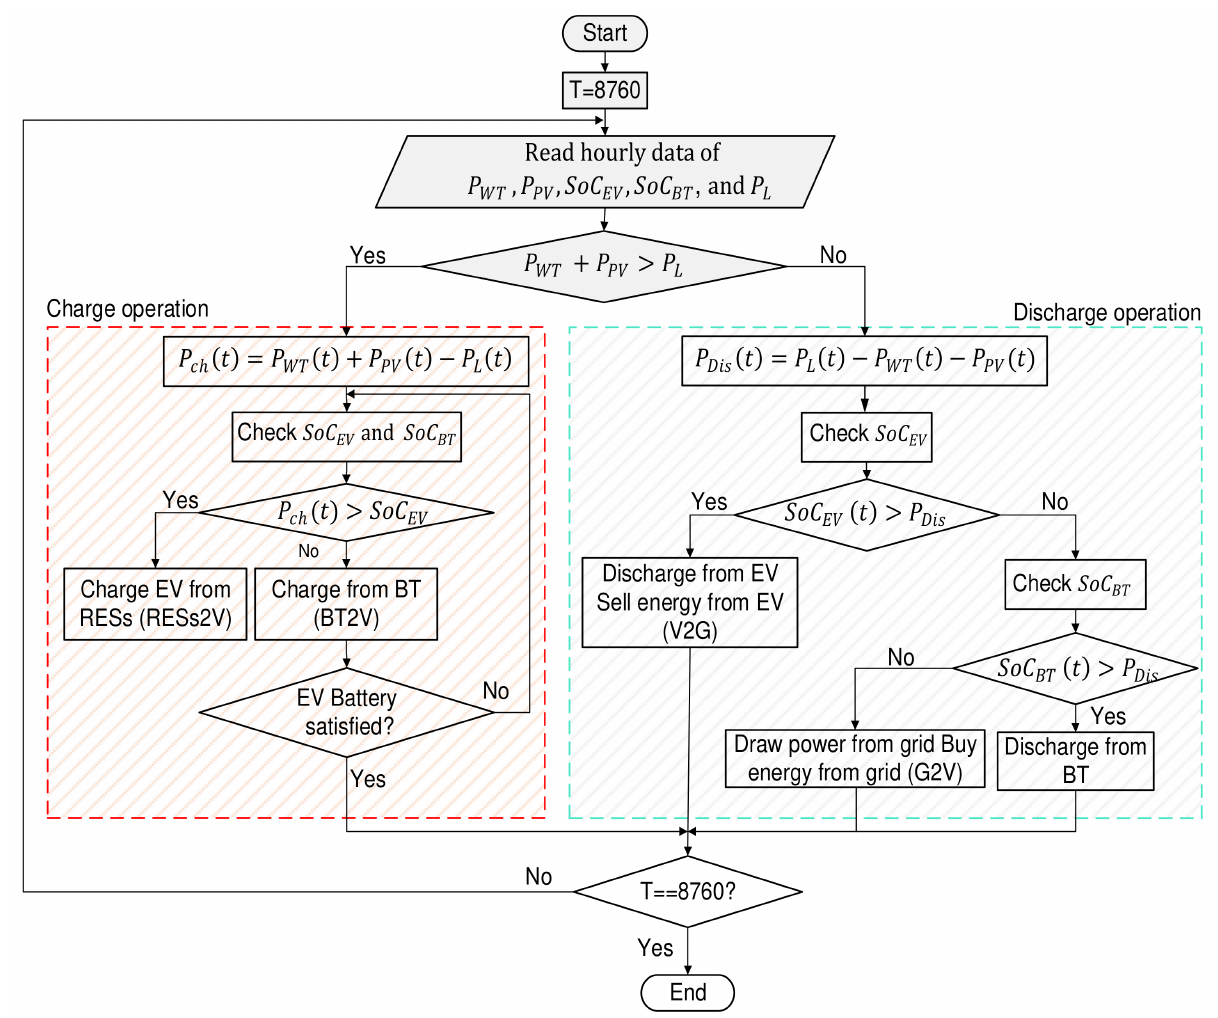
Figure 7. IF-Then conditions operations for